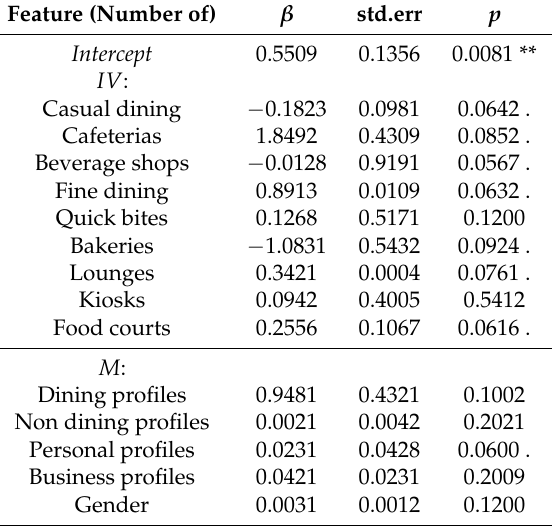
Table A1. Summary of regression results of mediation analysis: independent variables ( IV ), mediator between 6:00 a.m.–12:00 p.m. The results for IV are presented with Dining profiles as the